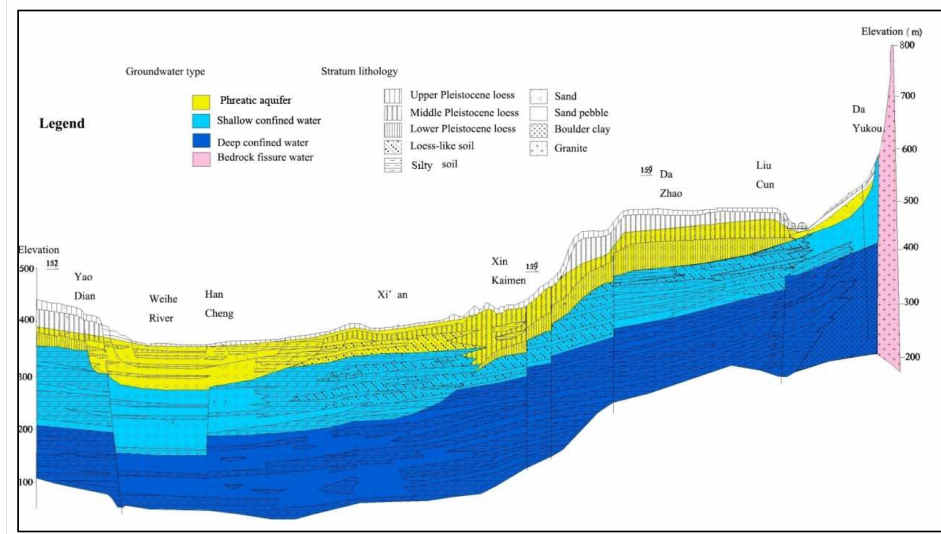
Figure 2. A hydrogeological map of